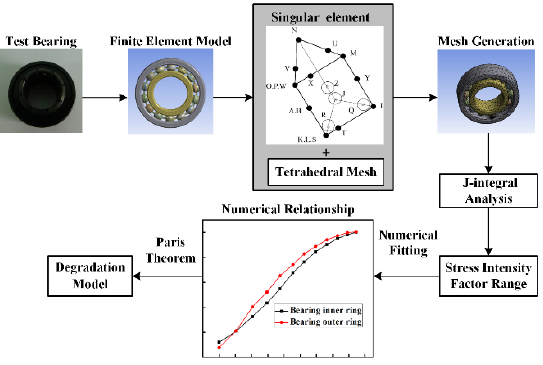
Figure 1. Time-varying parameter degradation model of bearings.